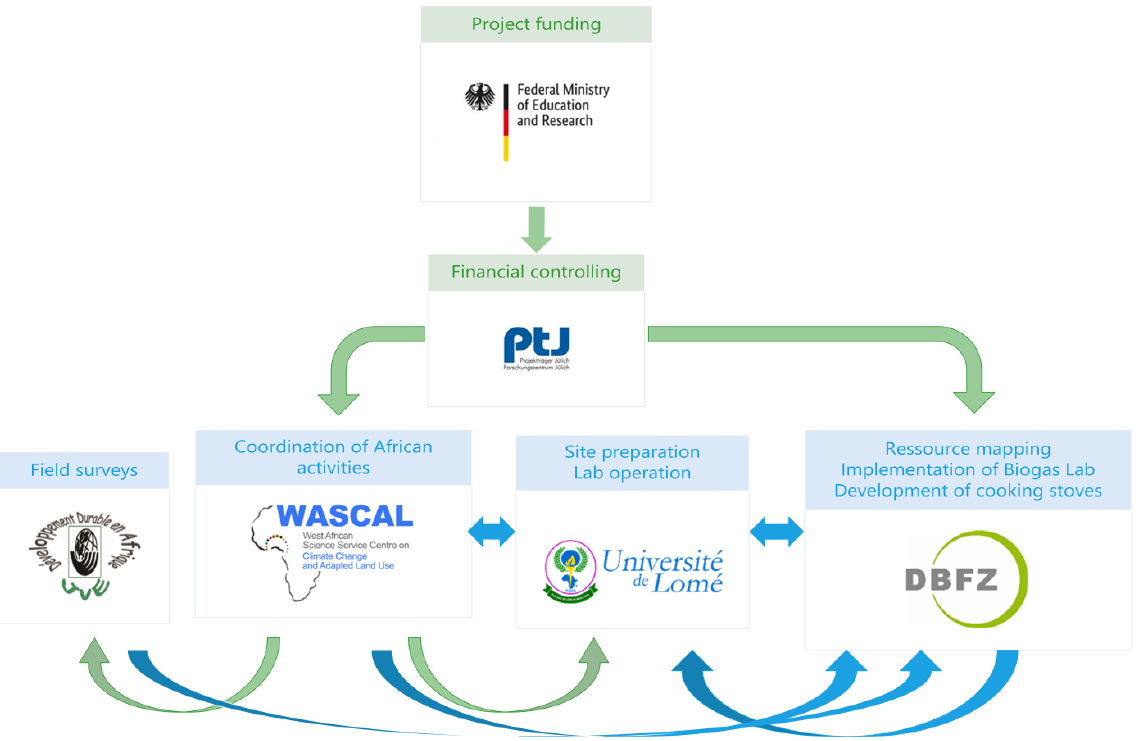
Figure 1 : Structure of the project (green arrows: funding, blue arrows: information and product